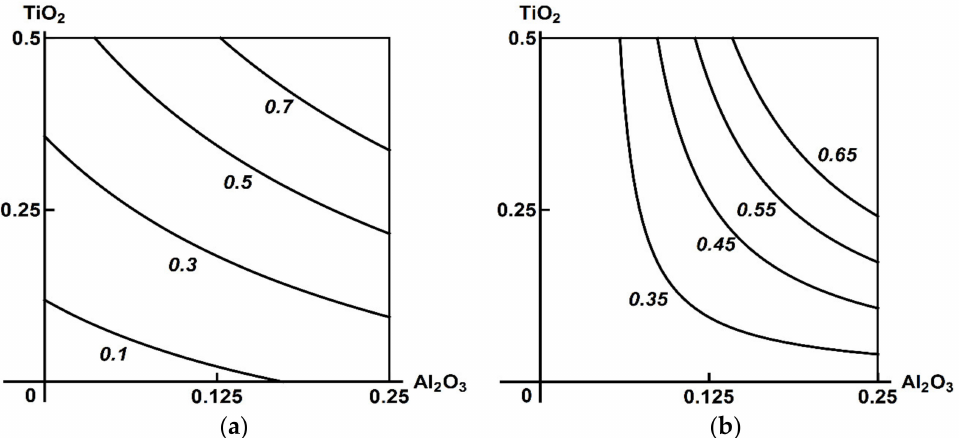
Figure 5. An example of Class A three-factor toxicity. The isobolograms of Al 2 O 3 + TiO 2 combined subchronic nephrotoxicity as assessed by desquamation of renal tubular epithelial cells as follows: ( a ) additivity of the unidirectional actions in the absence of a third agent; ( b ) synergism in the presence of SiO 2 NPs. MeO NP doses on the axes are plotted in mg per rat. Numbers on the isoboles show effect values (in %).